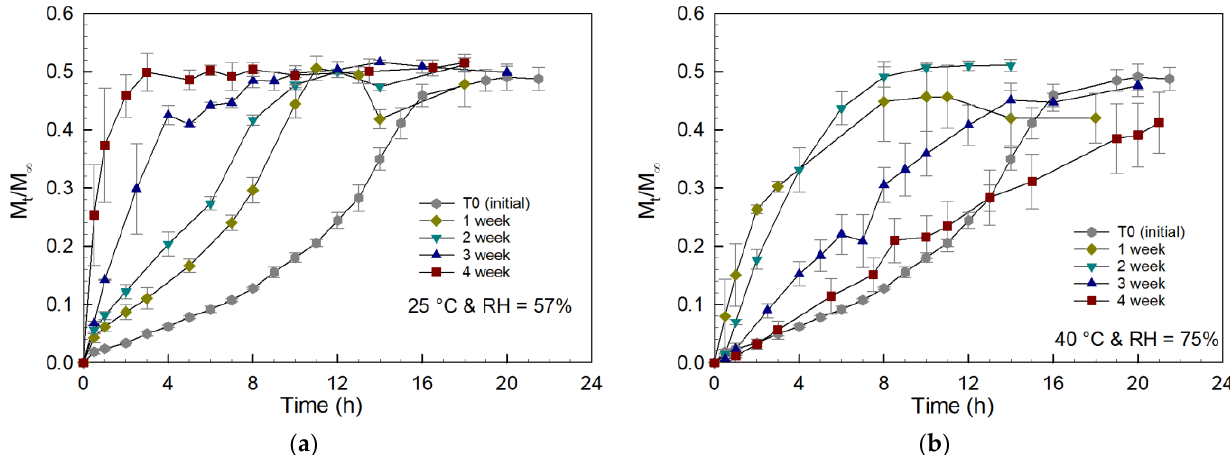
Figure 6. Curcumin release profiles from dissolution of PCBAE prodrug tablets stored at ( a ) standard conditions of 25 ◦ C and RH = 57%; ( b ) accelerated conditions of 40 ◦ C and RH = 75% with analysis using UV – Vis method.